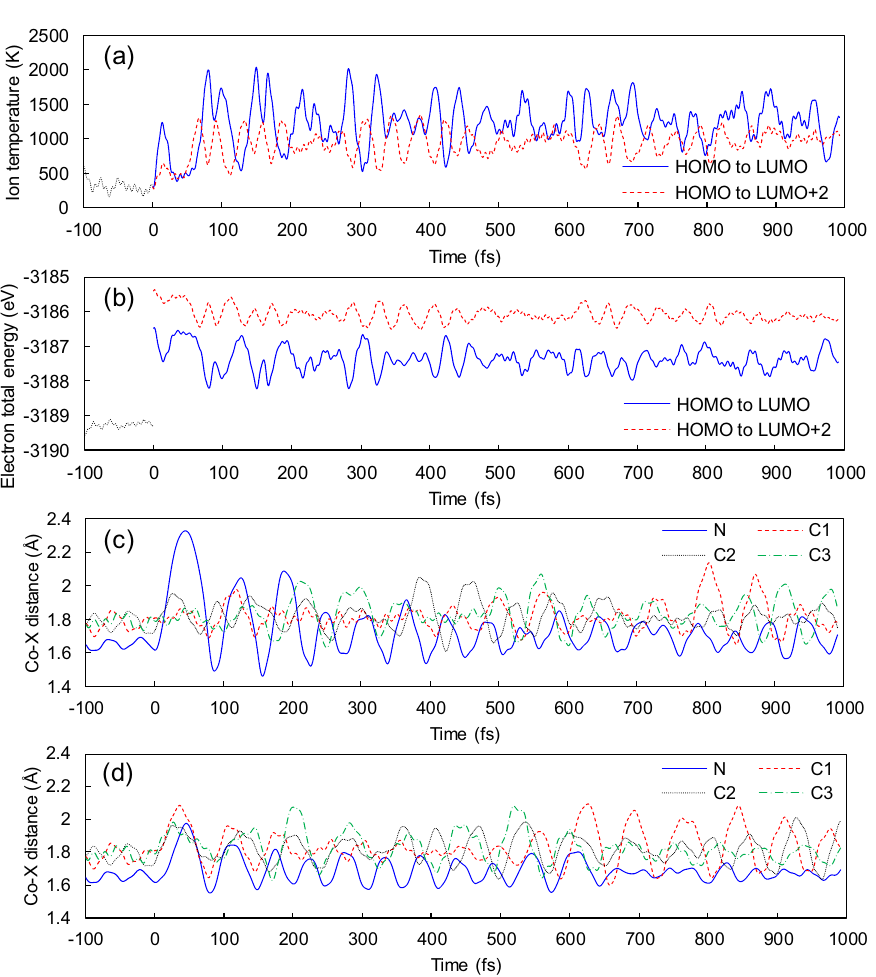
Figure 3. Excited-state dynamics. ( a ) Ion temperature and ( b ) electron total energy as functions of time, where the electron total energy includes ion-ion potential energy. First, systems are equilibrated at 300 K from − 100 to 0 fs; next, HOMO-to-LUMO and HOMO-to-LUMO + 2 excitations are induced at 0 fs; then, the excited states evolve in time from 0 to 1000 fs. Time evolution of Co-X distances induced by ( c ) HOMO-to-LUMO and ( d ) HOMO-to-LUMO + 2 excitations (X = N, C1, C2,